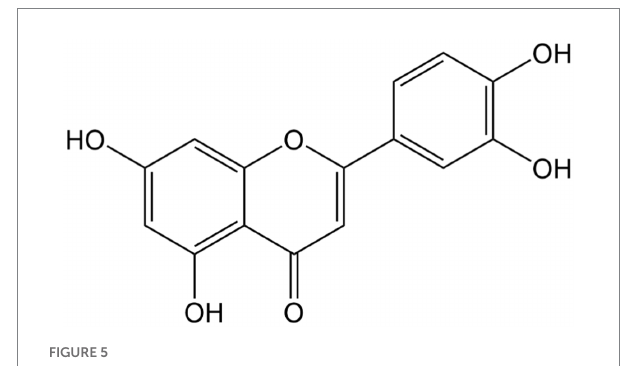
FIGURE 5 Chemical structure of